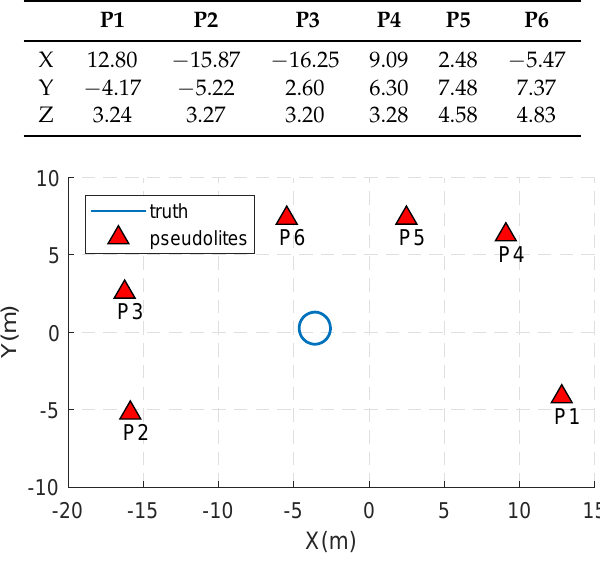
Figure 6. The horizontal diagram of the experiment configuration.